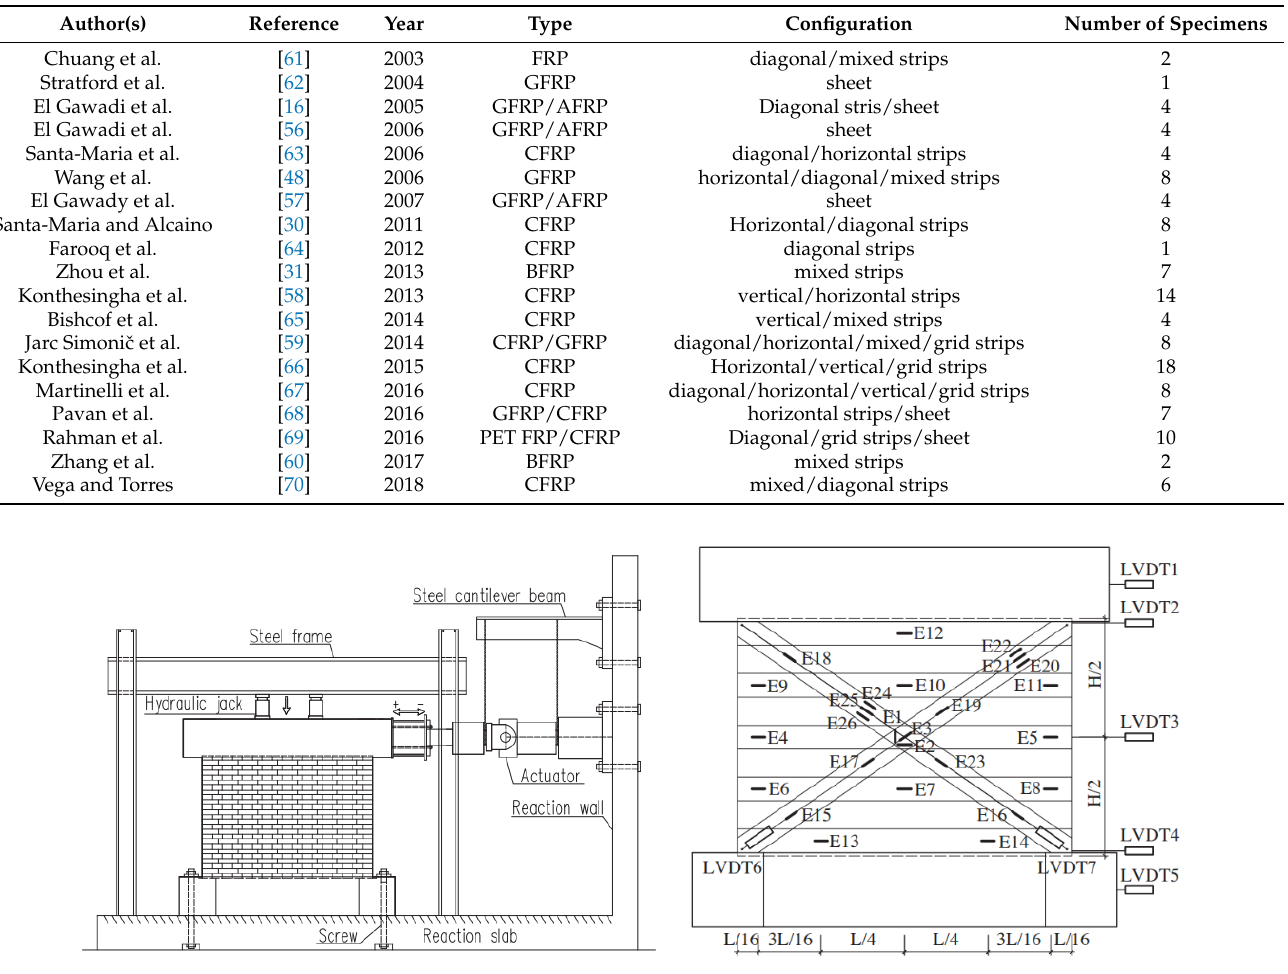
Figure 6. CFRP reinforcement URM walls tests [30]: ( a ) Overall dimensions of the walls and config ‐ urations of the CFRP reinforcement, ( b ) Cracking pattern and failure modes of repaired and